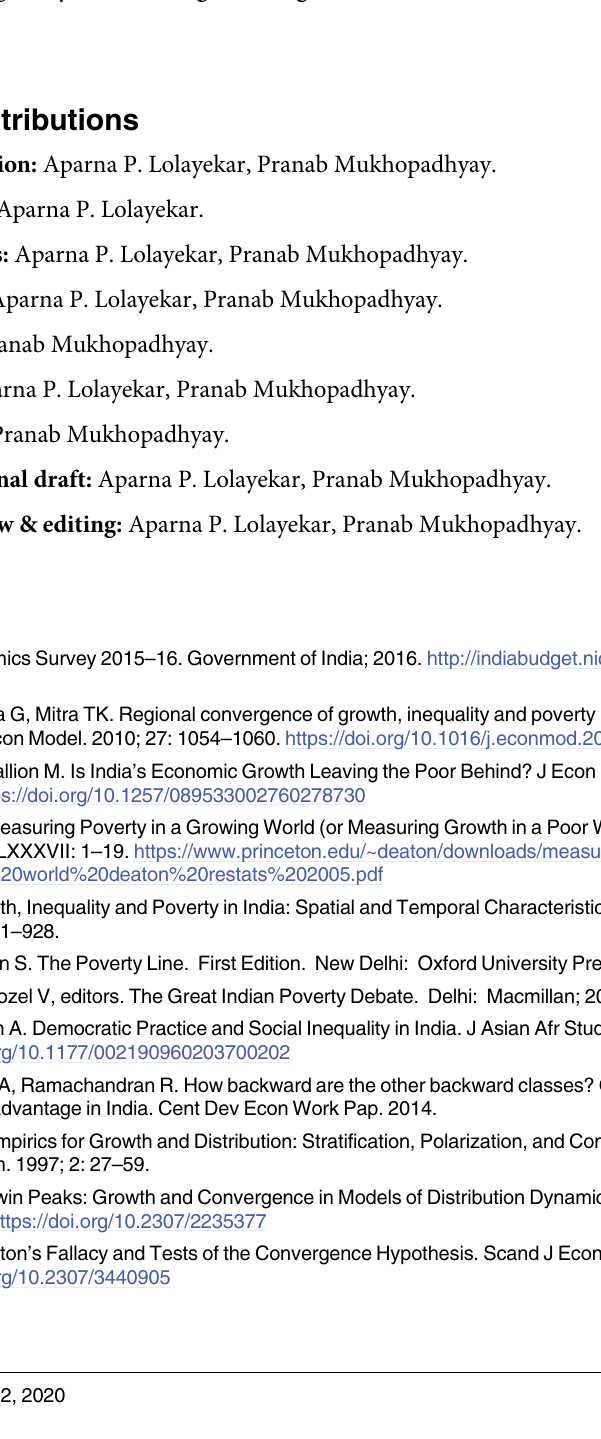
S1 Table. Normality tests. S2 Table. Correlation matrix. S3 Table. Test for variation in SC, ST. S4 Table. Endogeneity test of endogenous